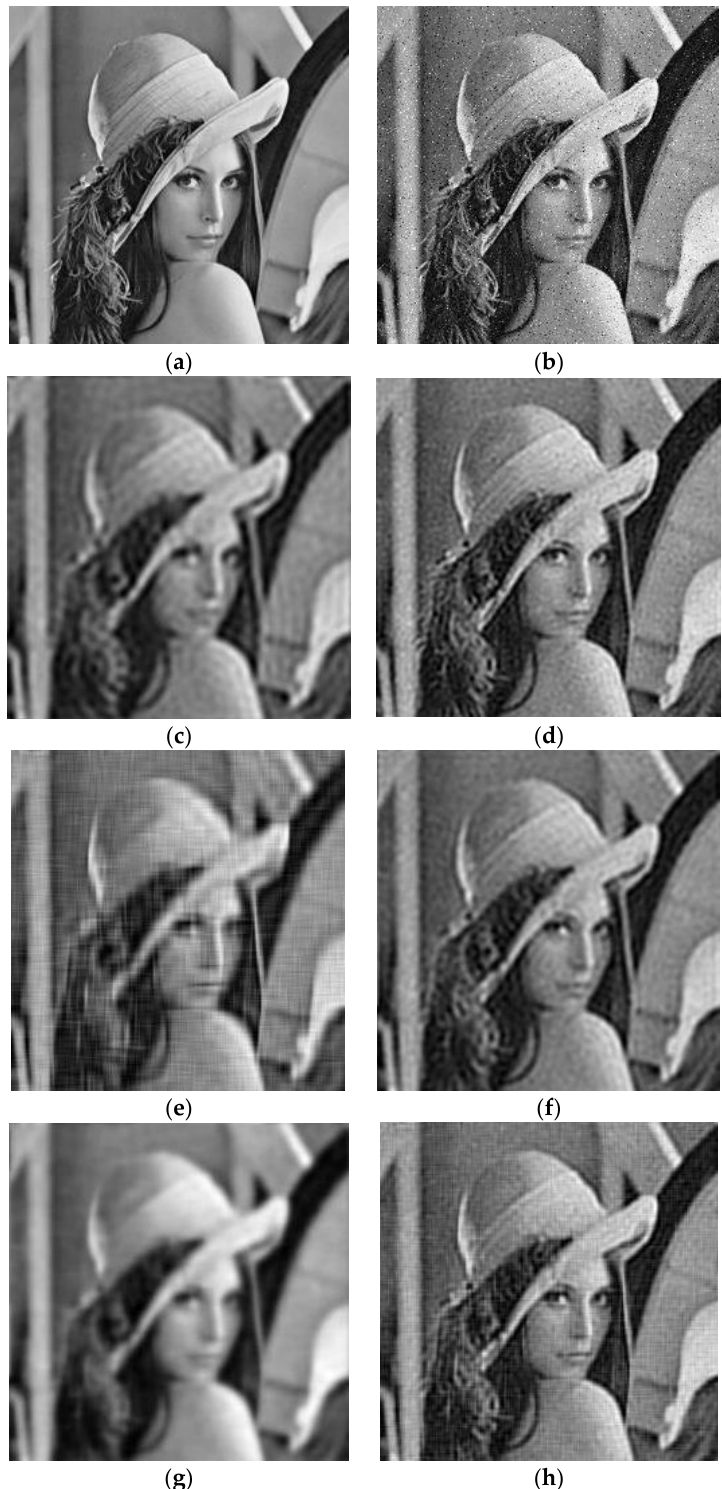
Figure 4. Visual comparison of the different designed filters. ( a ) Original image, ( b ) corrupted image, ( c ) filtering with PSO, ( d ) filtering with ABC, ( e ) filtering with DE, ( f ) filtering with HS, ( g ) filtering with GSA and ( h ) filtering with FPA.